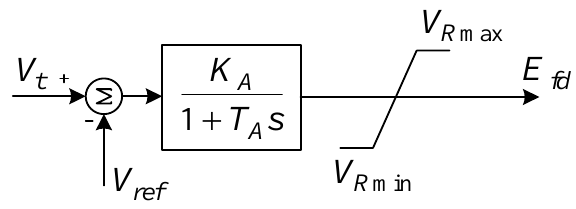
Figure 1. Schematic diagram of fast exciter [20].